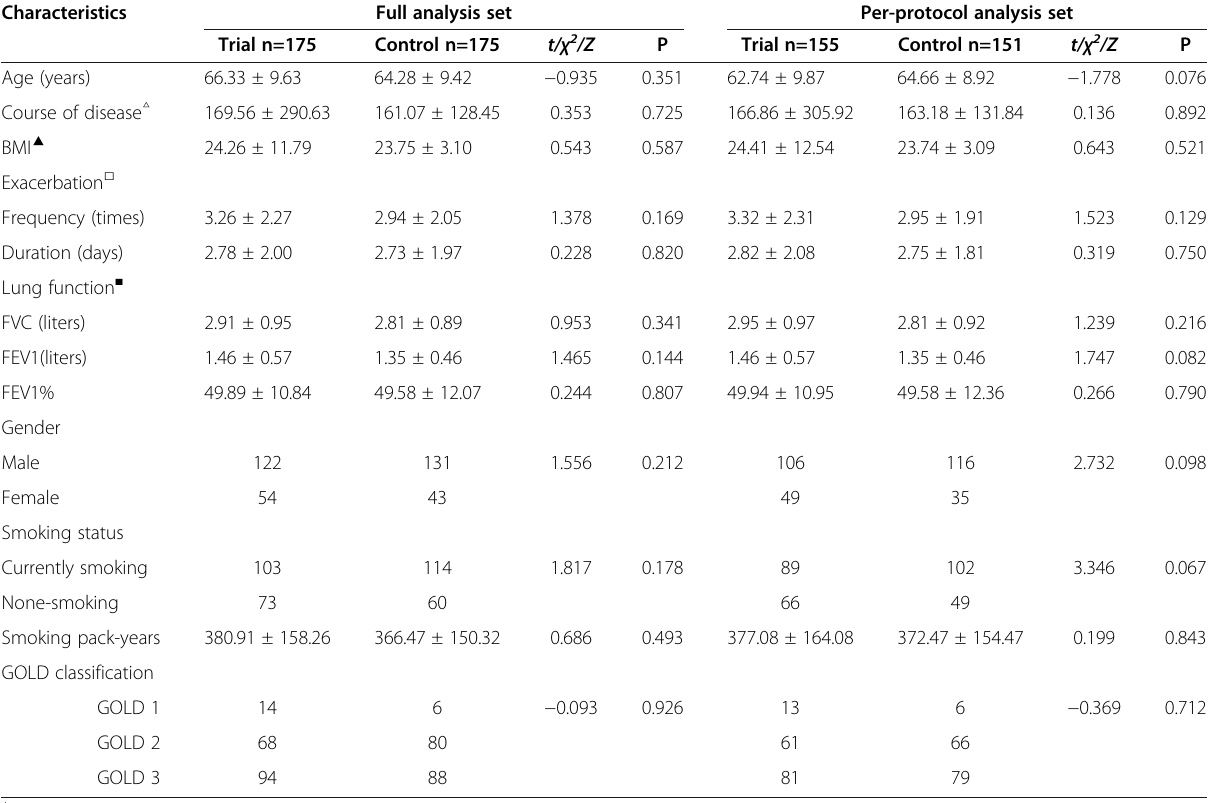
Table 3 Baseline characteristics of the patients Characteristics